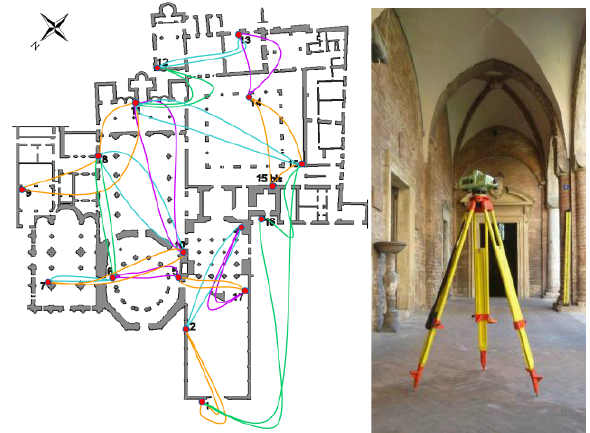
Figure 8. The leveling network consisting in 17 benchmarks (left); the digital level, DNA03 by Leica Geosystems , during the leveling campaign in St. Stefano Basilica.